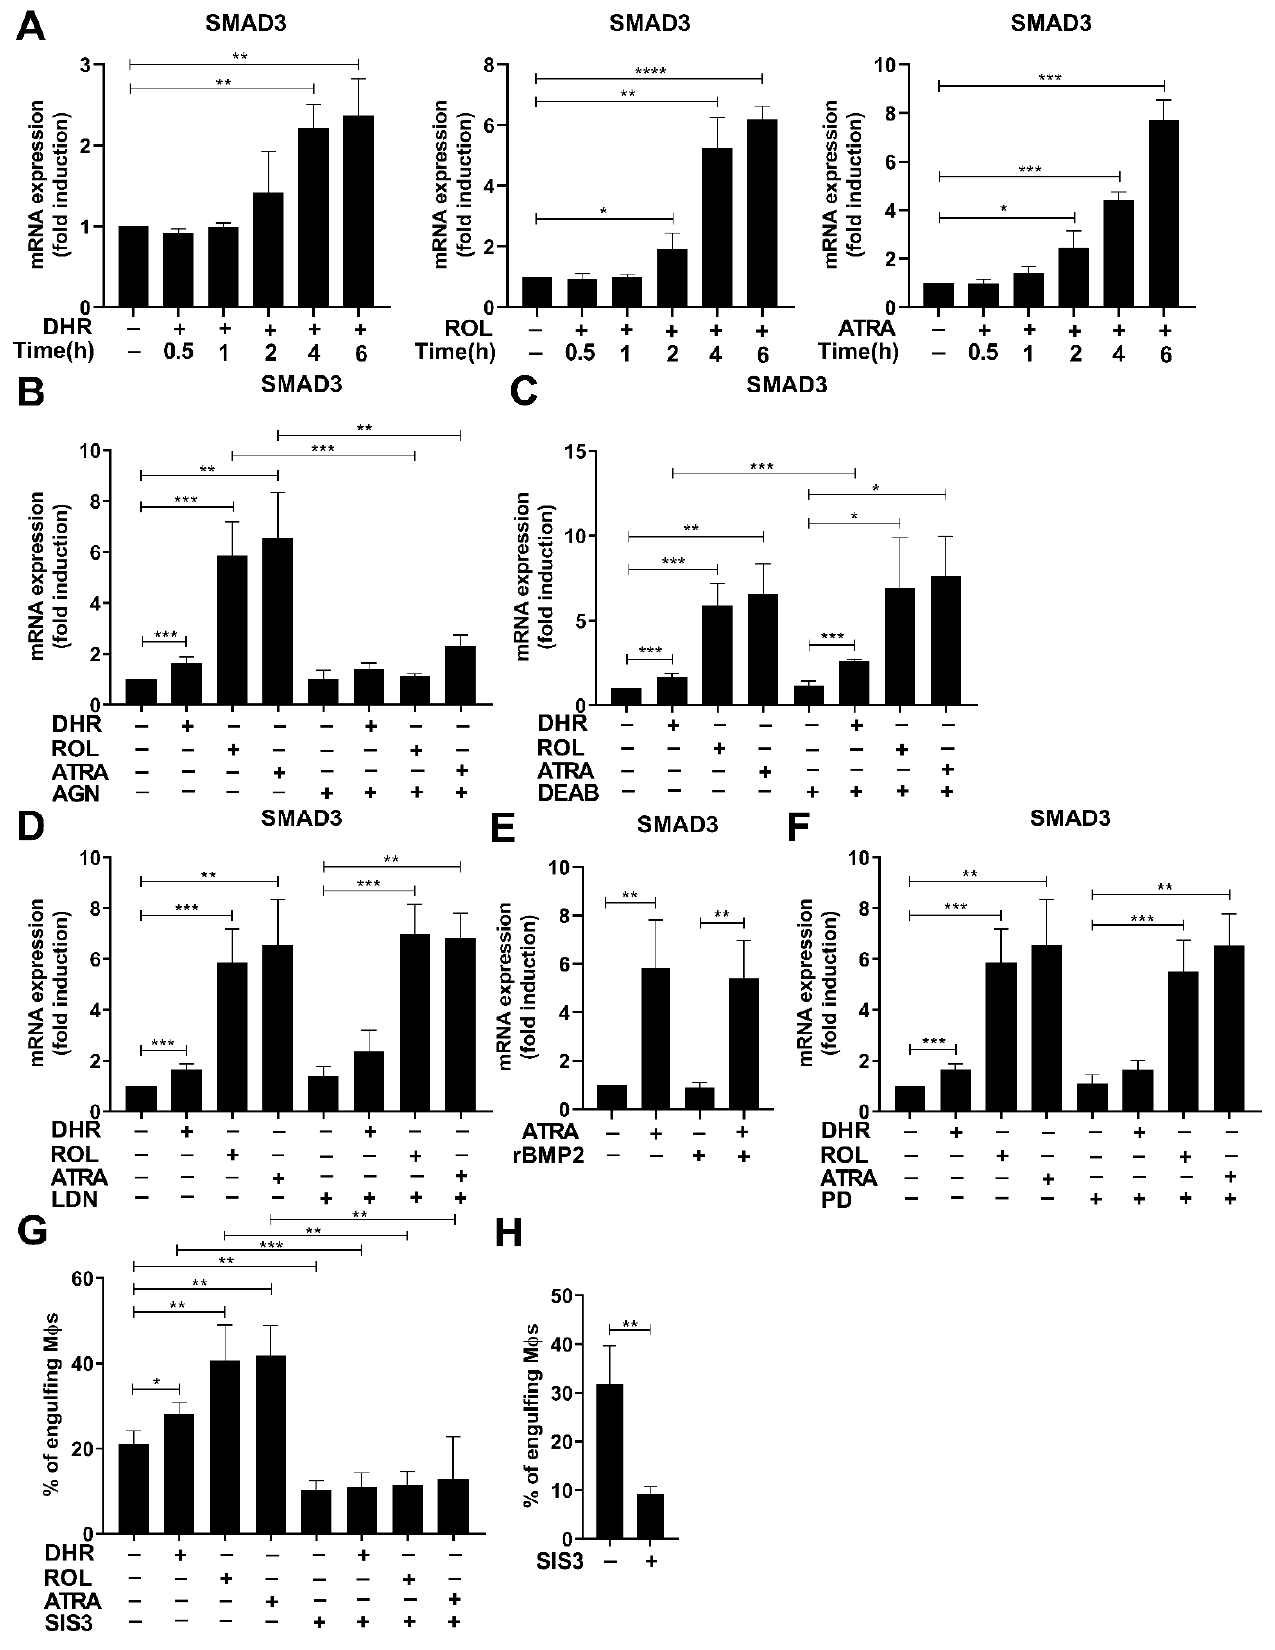
Figure 4. Smad3 is induced by retinoids during macrophage differentiation and contributes to retinoid-enhanced efferocytosis. ( A ) Time-dependent increase in the Smad3 mRNA expression